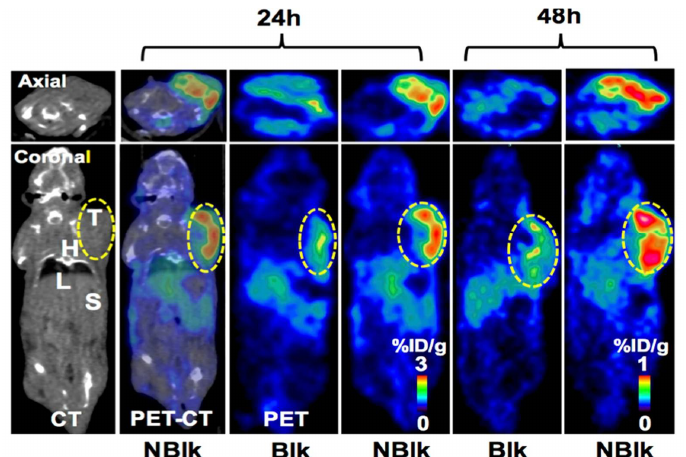
Figure 2. PET/CT image showing [ 64 Cu]Cu-DOTA-Pembrolizumab immunoPET in the hNSG/A375 mouse model. Representative PET/CT axial and coronal images displayed at 24 and 48 h post-injec- tion of tracer (7.4 MBq/200 µL) in hNSG/A375-blk and hNSG/A375-nblk mice. T, tumor; H, heart; L, liver; S, spleen. Adapted with permission from [22].